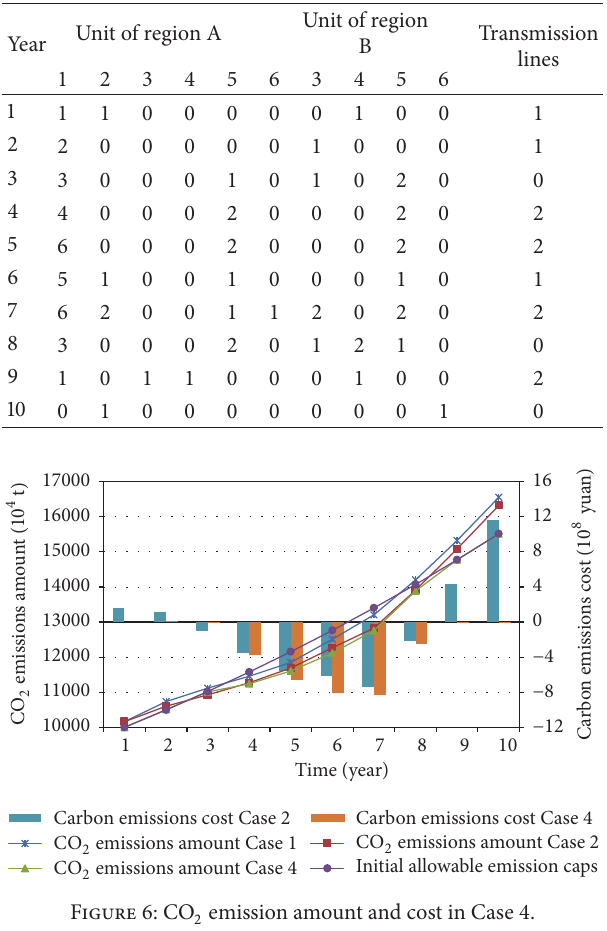
Table 14: Power system planning optimized result in Case 4.